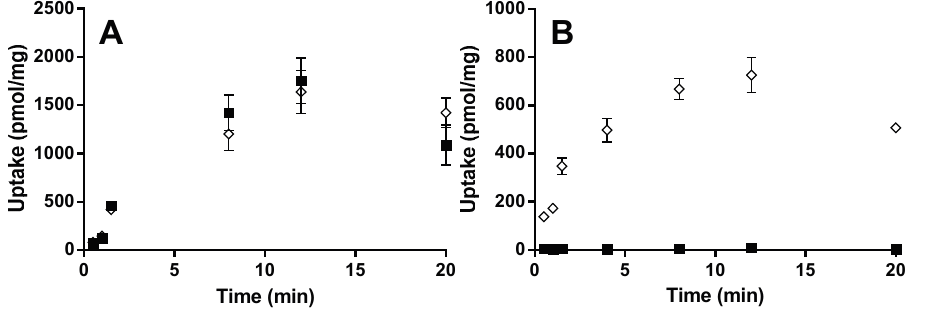
Figure 3. Time-dependent uptake of ( A ) 1 µM montelukast and ( B ) 1 µM E 2 17 β G in HEK-OATP1B1 ( ◊ ) and HEK-mock cells ( ■ ) at pH 7.4. Results are given as mean ± S.D., n =